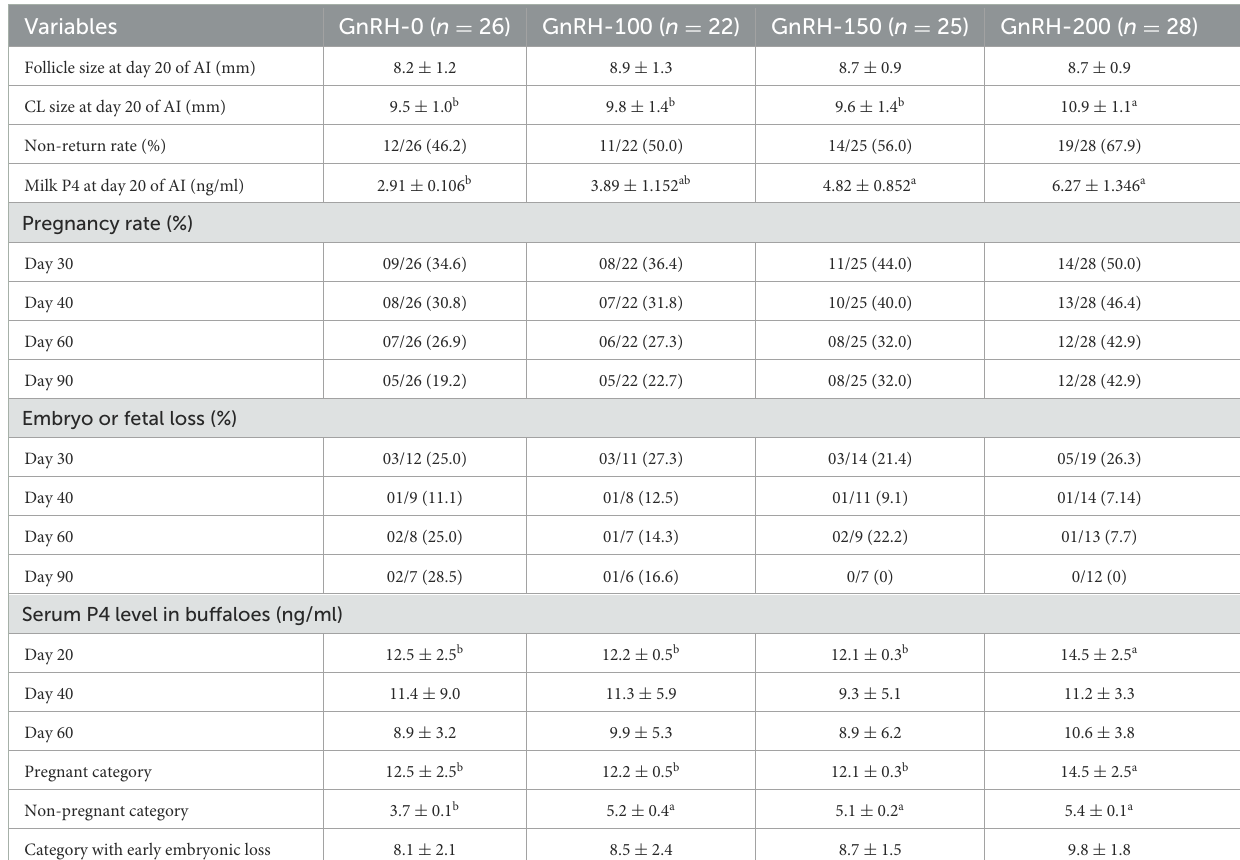
TABLE 1 Effect of different doses of GnRH at day 20 of AI on follicle or CL size, non-return rate, pregnancy rate, embryonic or fetal losses, and seum/milk P4 level in post-partum buffaloes. Variables